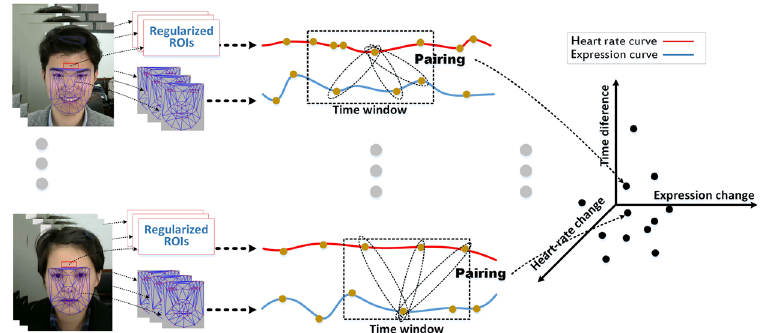
Figure 7. Overview of the method composed of tracking, pairing and